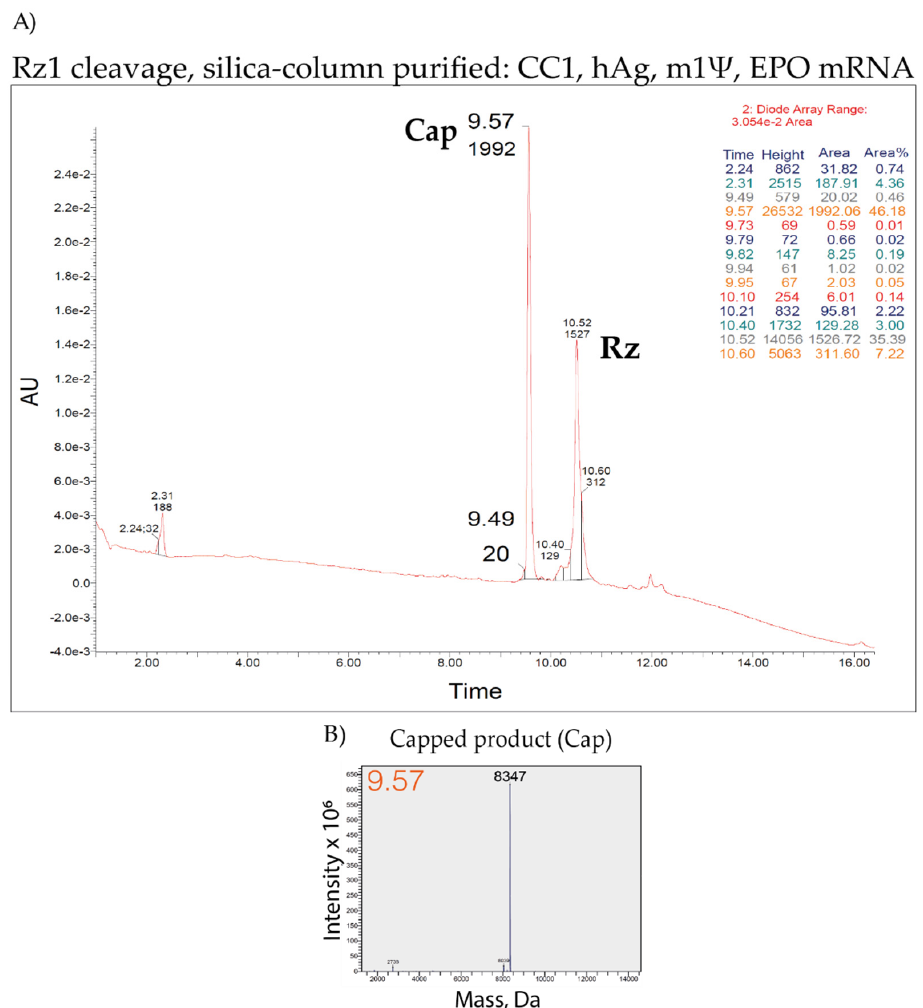
Figure 8. LC–MS analysis of ribozyme-mediated cleavage products for quantification and charac- terization of capped products from Rz1 cleaved and silica-column purified CleanCap ® Reagent AG (3 ′ OMe) = cap1 (CC1), human alpha globin (hAg), m1 Ψ -containing erythropoietin (EPO) mRNA. Expected capped product (MW = 8347) is detected in >99%. ( A ) UPLC and ( B ) MS profiles. Rz: Ribozyme; Cap: Capped product; AU: Arbitrary units.